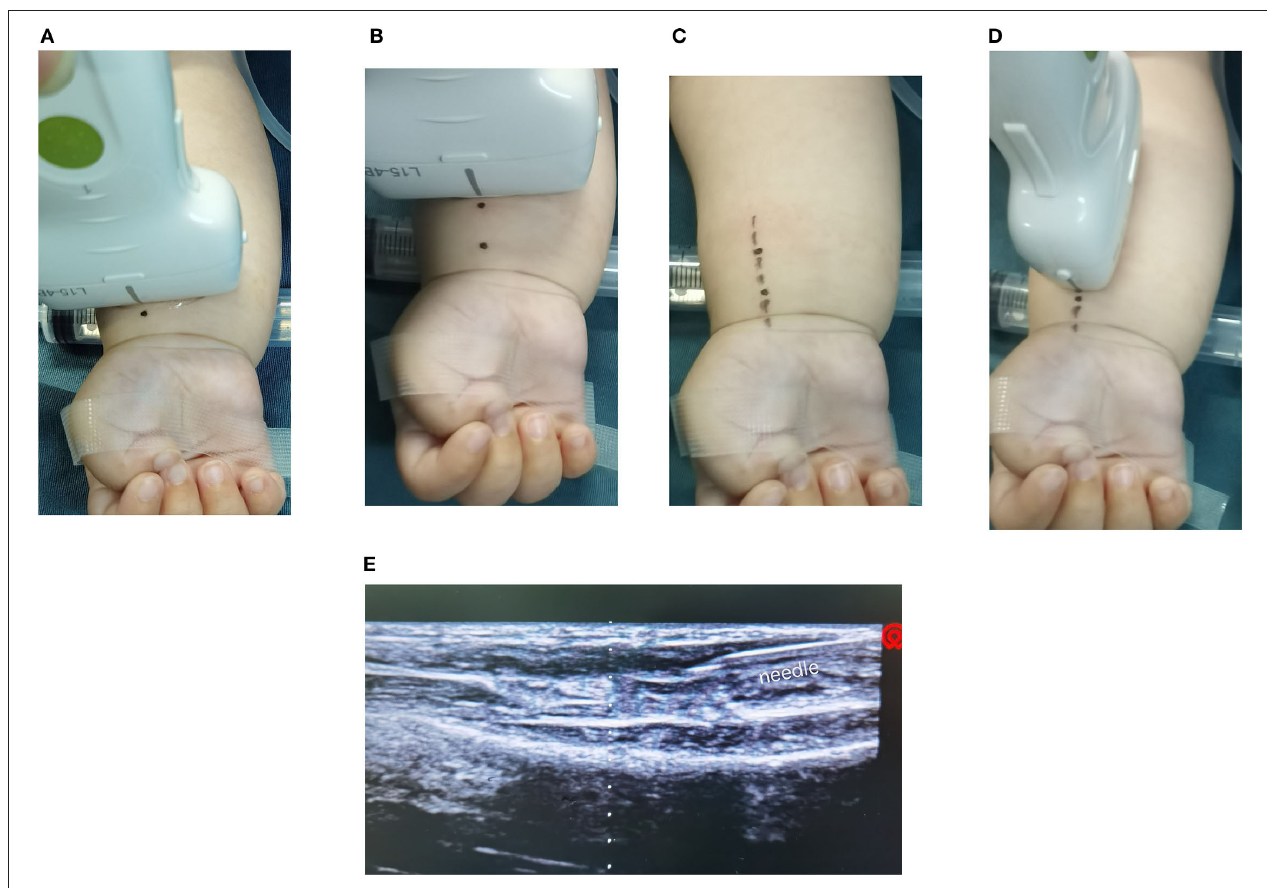
FIGURE 1 | (A–E) The radial artery was marked on the skin using the MLAX-IP technique.